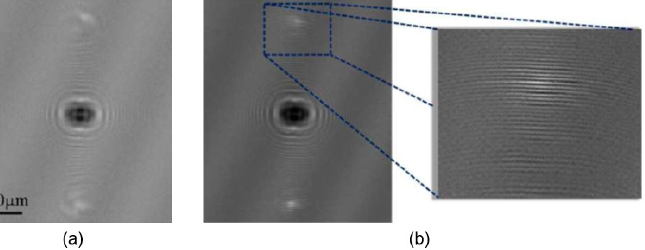
Figure 6. Pixel super-resolution hologram comparison [47]. ( a ) Before pixel super-resolution. ( b ) After pixel super-resolution.